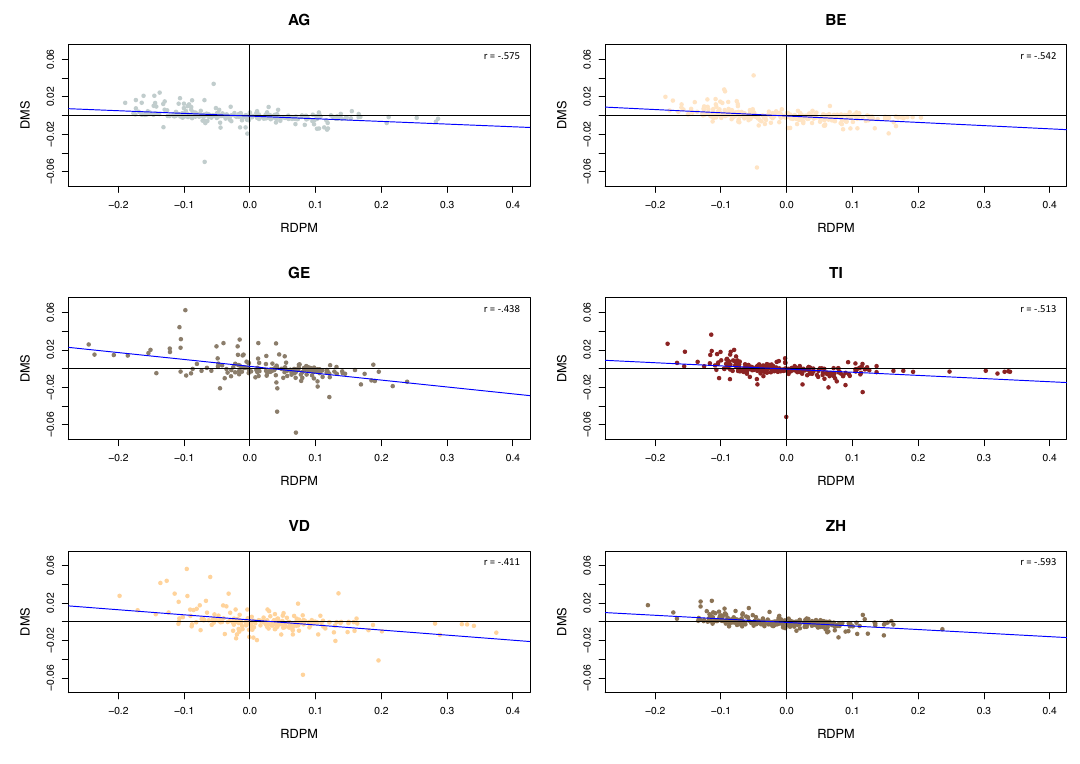
Figure 10. RDPM versus DMS in selected